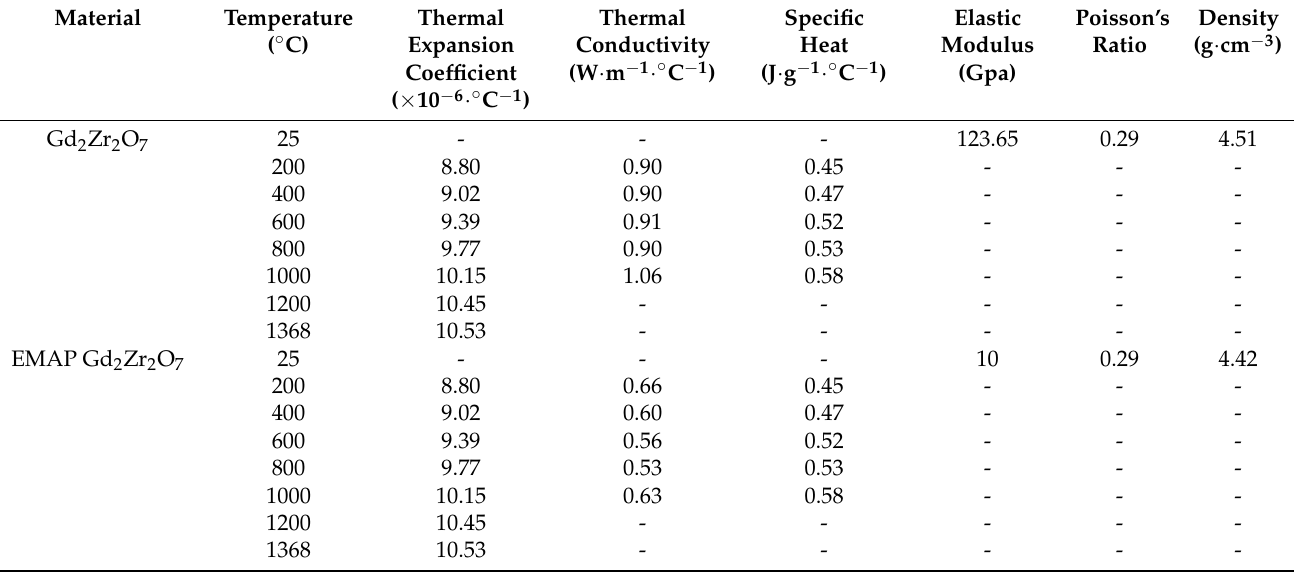
Table A3. Thermophysical parameters of